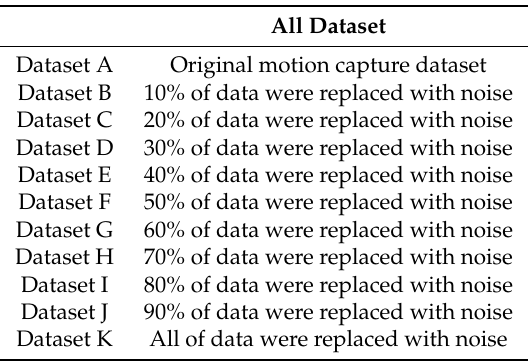
Figure 10. Three examples of supervised training data collected for assumed scenario 1: ( a ) dataset A: AGV trajectories captured by motion capture, ( b ) dataset F: AGV trajectories with random noise, and ( c ) dataset K: only random noise data. Table 2. Overview of all